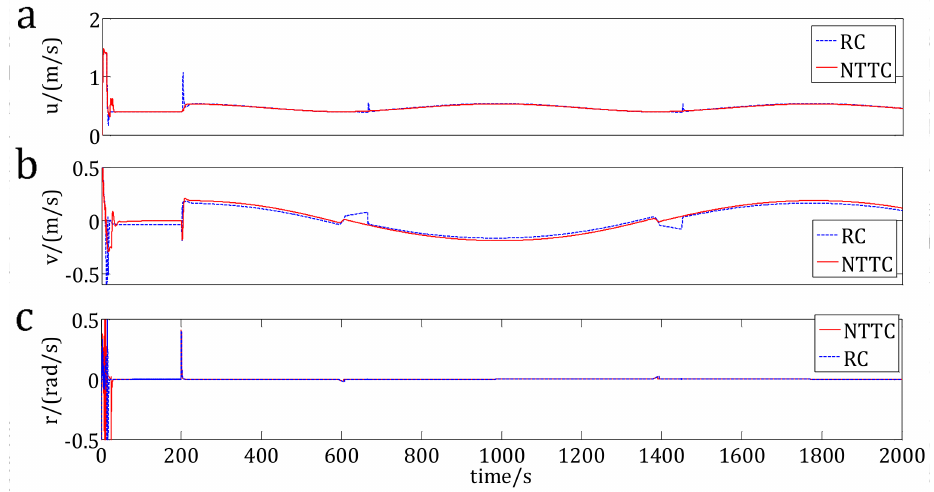
Figure 10. Velocities of the USV. ( a ) Surge velocities of the USV using the RC and NTTC method; ( b ) Sway velocities of the USV using the RC and NTTC method; ( c ) Yaw velocities of the USV using the RC and NTTC